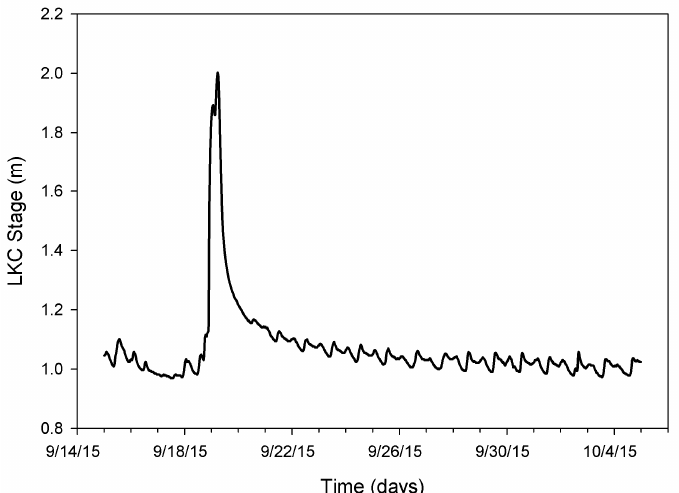
Figure 2. Representative hydrograph of LKC pre-and post-storm event. Stage increases rapidly to a peak of 2 m, which is approximately 1 m of change from baseflow. Other storm events produced similar trends.